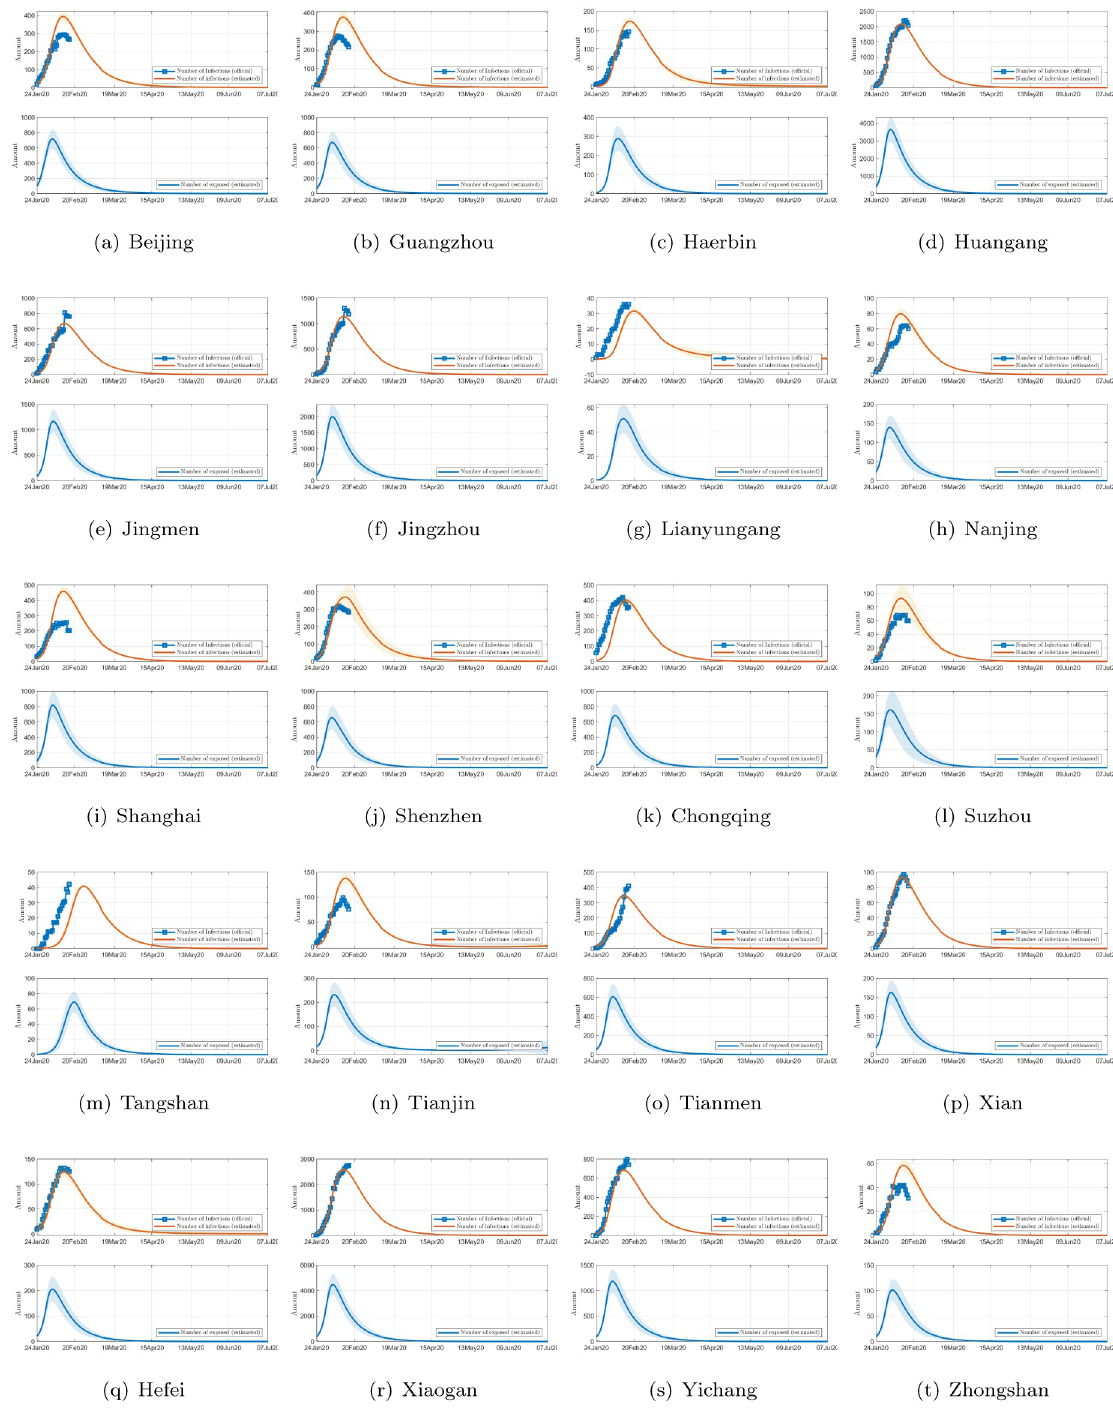
Fig 5. Prediction of the number of infected (upper) and exposed individuals (lower) in 20 selected cites in China for the next 150 days. The shaded band is the 95% confidence interval.